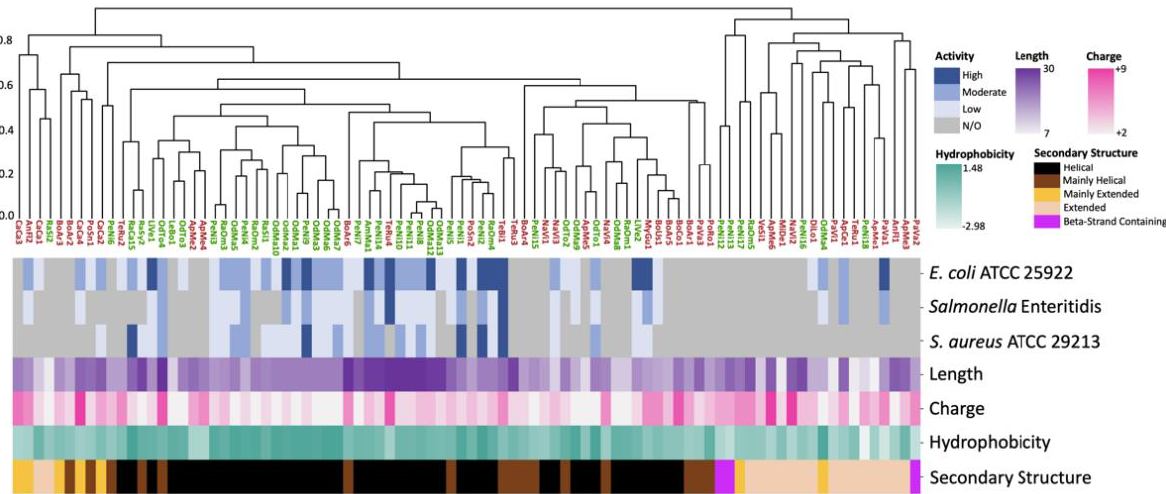
Figure 1. Agglomerative hierarchical clustering of peptides based on their predicted 3D structures. The bioactivity of each peptide against the three organisms tested ( E. coli ATCC 25922, Salmonella Enteritidis, and S. aureus ATCC 29213) is reported in the top three rows. Bioactivity is assigned based on the median MIC and categorized as high for peptides with a MIC ≤ 4 μg/mL, moderate for 4 < MIC ≤ 16 μg/mL and low for 16 < MIC ≤ 128 μg/mL. Peptides that did not inhibit bacterial growth at tested concentrations were classified as ‘no inhibition observed’ (N/O). Physiochemical attributes of the AMPs tested (length, charge, and hydrophobicity) are displayed in rows 4, 5 and 6 using purple, pink and green gradients, respectively. The colour-coded peptide secondary structures (helical, mainly helical, mainly extended, linear extended and β -strand containing) shown in row 7 were assigned based on 3D coordinates of predicted structures. AMP name labels below the dendogram are colour-coded to indicate their amphibian (green) or insect (brown) origin.